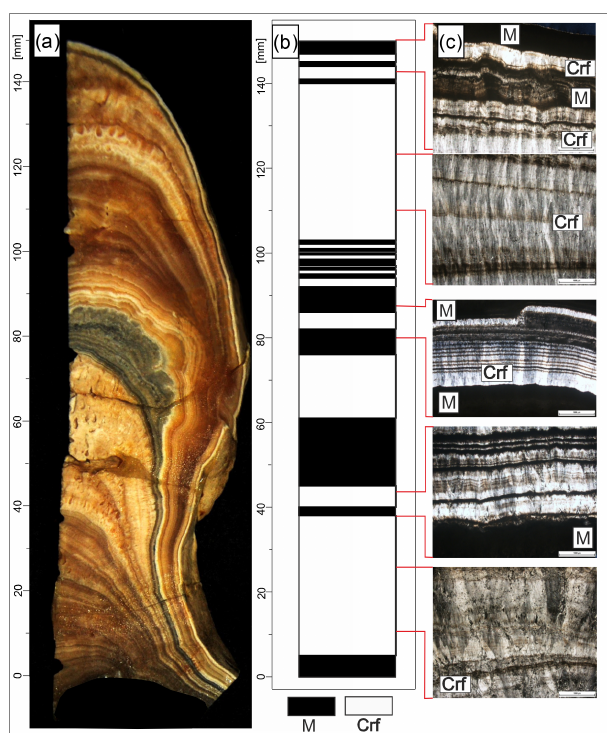
Figure 2. The JS9 sample lithology: (a) a photo of the JS9 stalag- mite, (b) a microfabric log scaled by distance from the base of the stalagmite and (c) exemplary photos of microfabrics. M denotes mi- crite fabric, and Crf denotes columnar radiaxial fibrous microfabric.